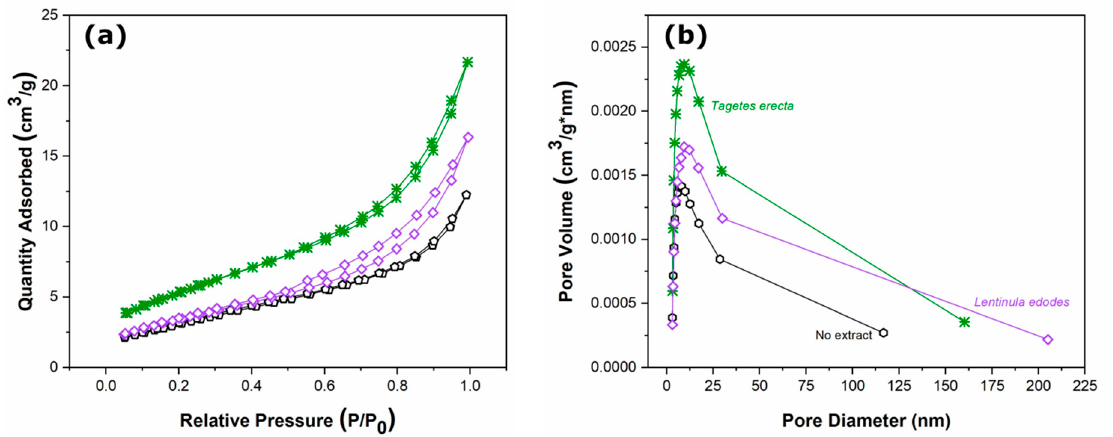
Figure 6. TGA thermograms of ZnO NPs synthesized with no extract and different botanical ex- tracts .